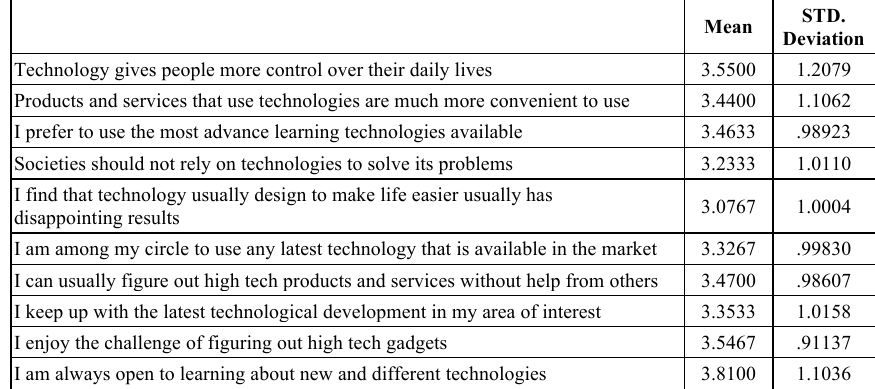
Table 4. Showing Means and std of students' response to Gen. Tech. questionnaire